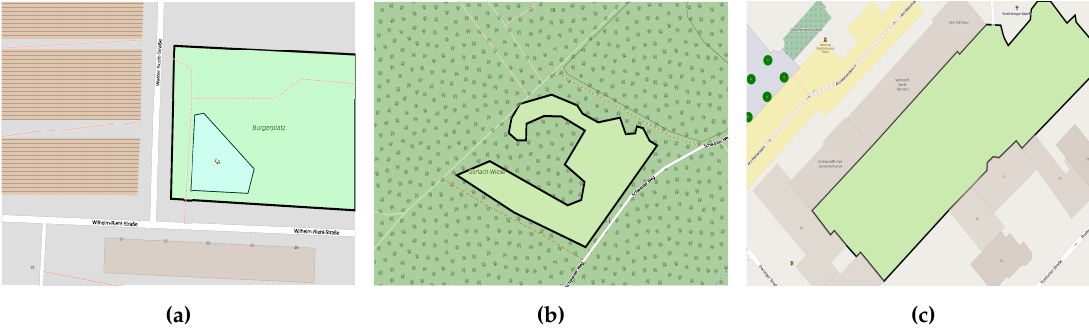
Figure 13. Visual investigation of participant contributions compared to the provided recommendations by our approach and the resulting enhanced data classification. ( a ) A participant followed our recommendation and confirmed the entity classification as park , ( b ) A participant followed our recommendation and corrected the entity classification from park to meadow , ( c ) A participant ignored our recommended garden class, and misclassified the entity as meadow